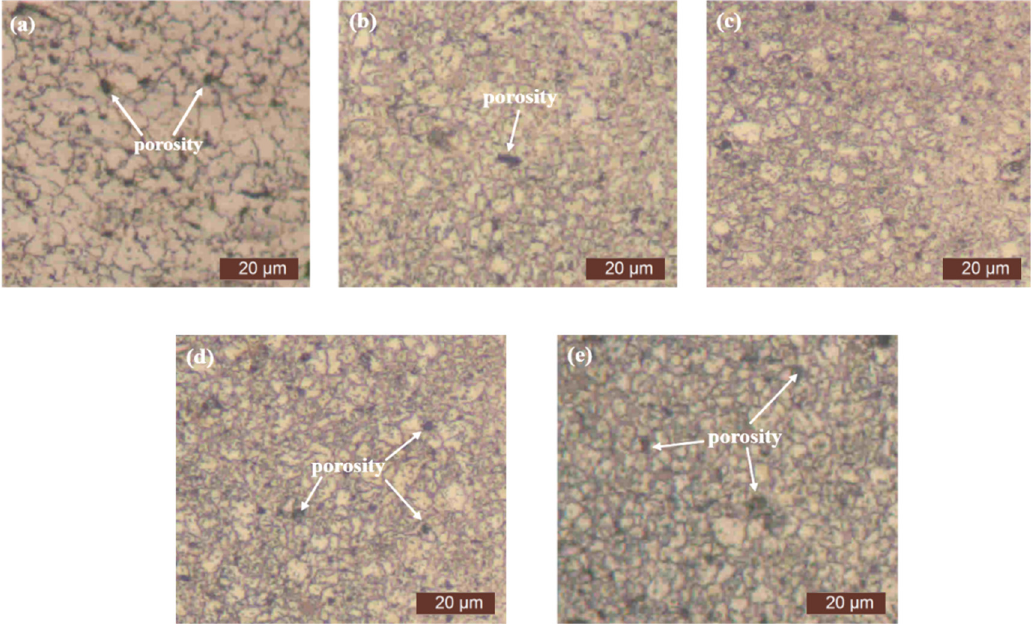
Figure 3. Microstructure of sintered samples ( a ) S1 ( b ) S2 ( c ) S3 ( d ) S4 ( e ) S5.